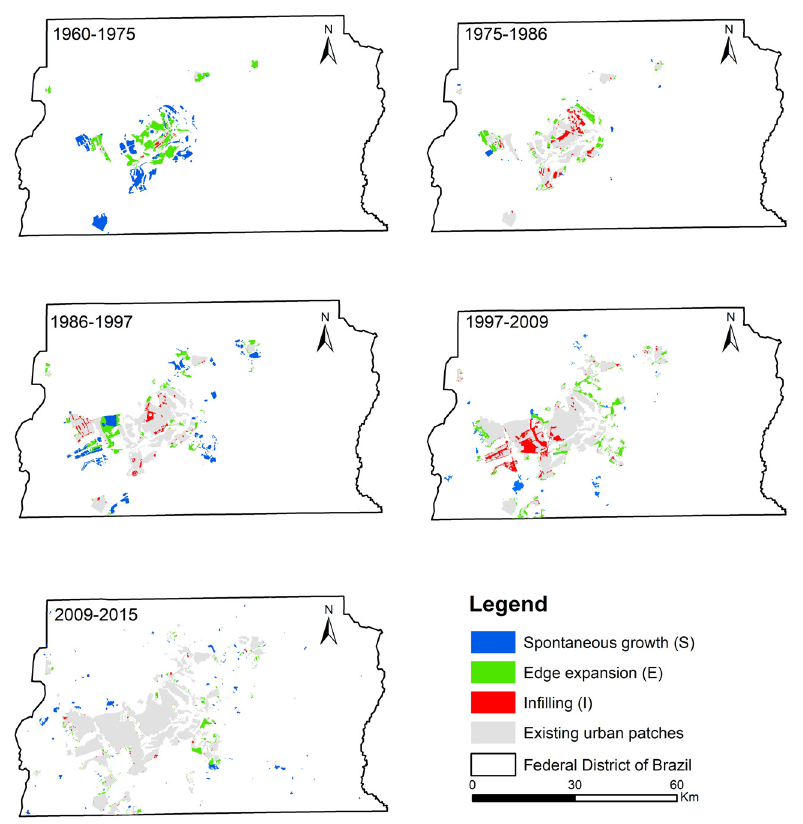
Figure 8. Spatial distribution of urban expansion types in the FDB during 1960–2015.